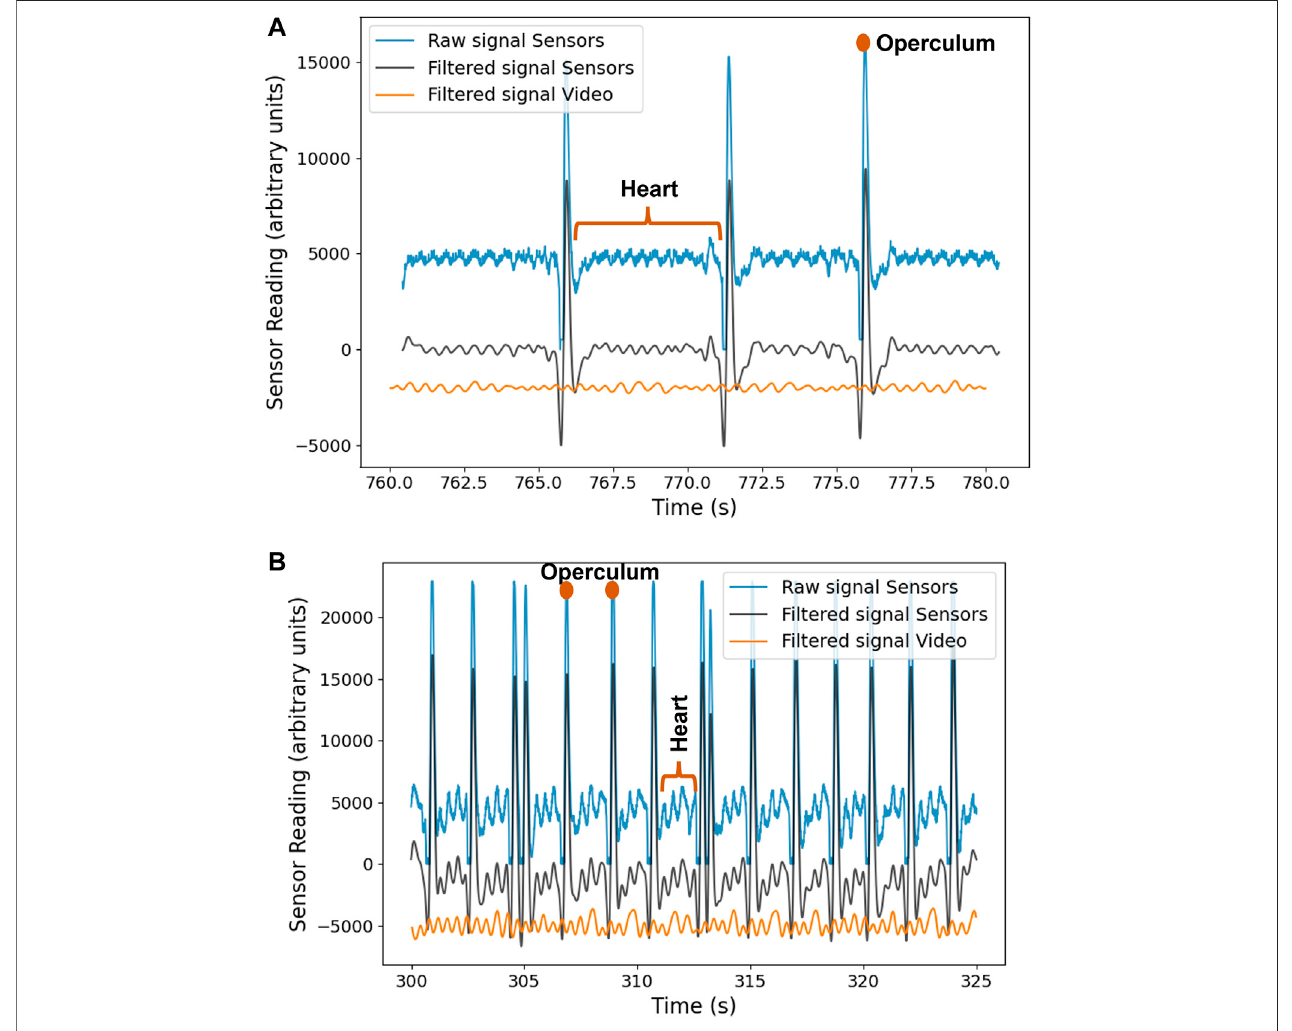
TABLE 2 | Zebra fi sh heart and operculum rates obtained with the sensors and video analysis